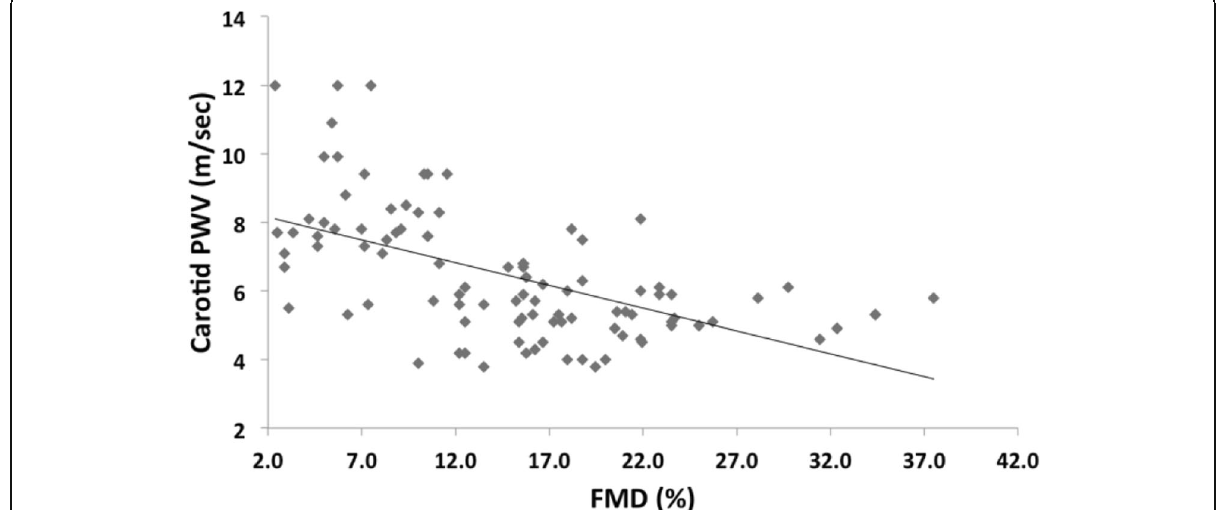
Fig. 4 Correlation between FMD and carotid PWV in SLE patients and